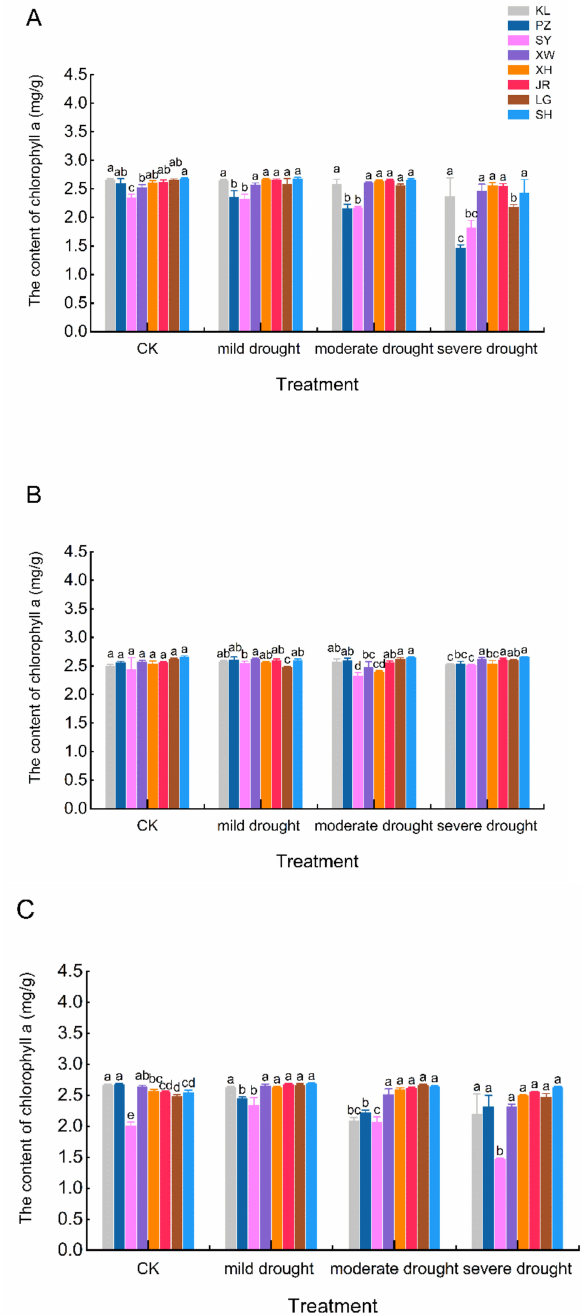
Figure 7. The chlorophyll a content of Melia azedarach among different provenances: ( A ): early stage, ( B ): middle stage, and ( C ): late stage. Note: The error line in the figure is the mean ± standard error, and different lowercase letters in the same treatment indicate significant differences at the 0.05